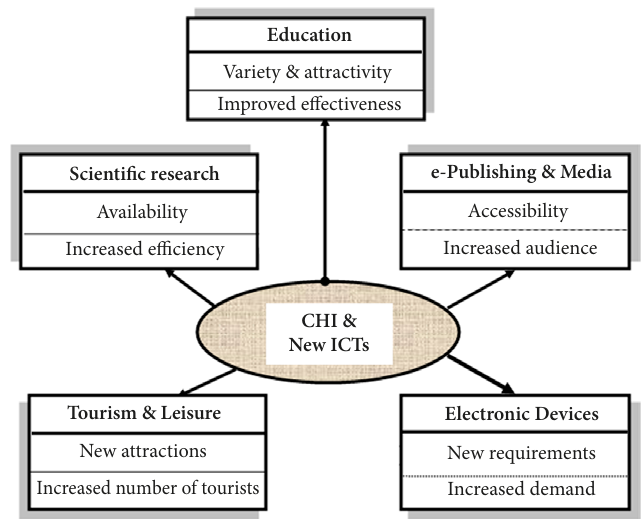
Fig. 1. Influences of modern CHI: sectors, characteristic features and expected impact Source : adapted from Filip et al.